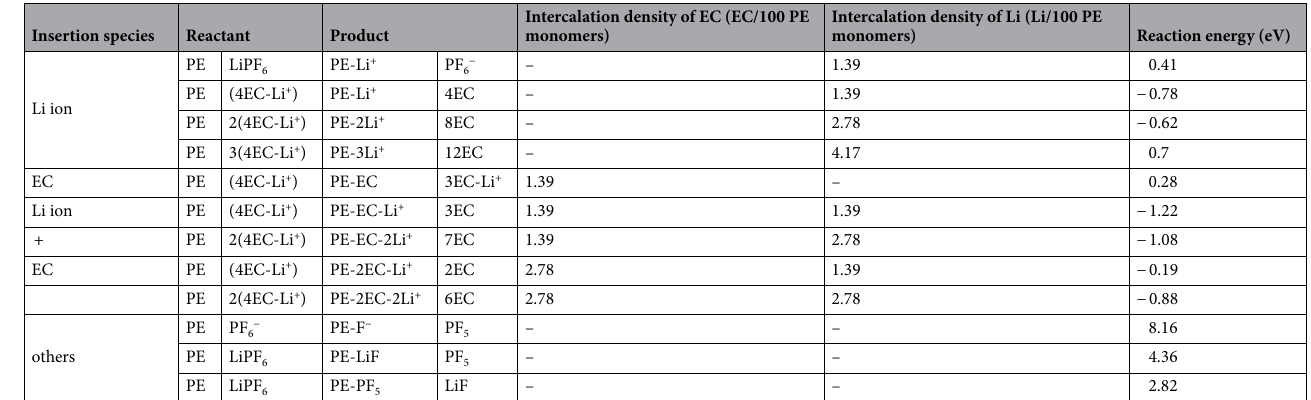
Table 3. Reaction energies of Li-insertion effects in PE.